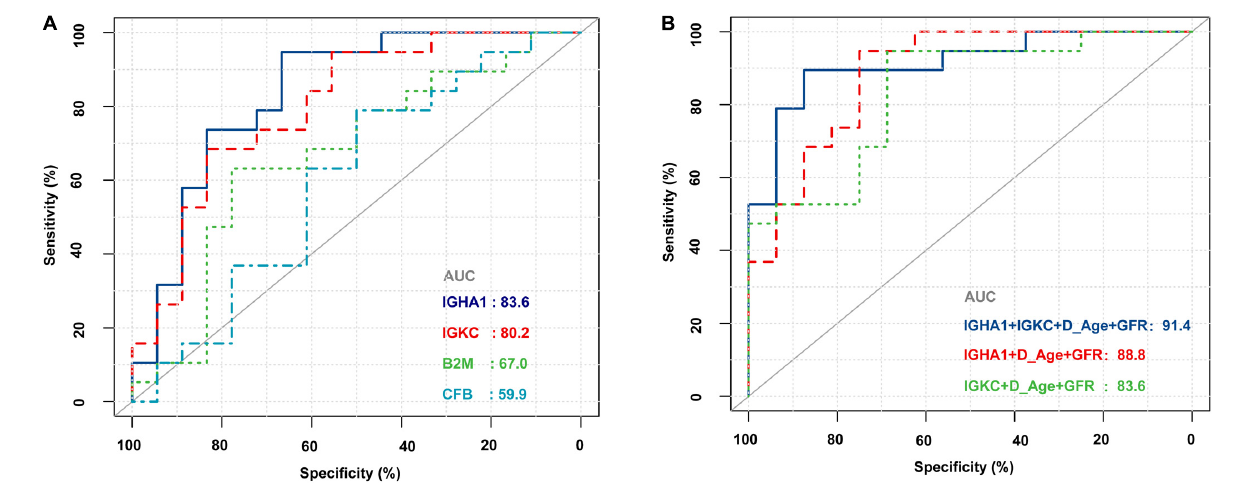
FIGURE 5 | Receiver operating characteristic (ROC) curves of B2M, CFB, IGHA1, and IGKC based on RNA sequencing in PBMCs of renal allograft transplant patients. (A) ROC of B2M, CFB, IGHA1, and IGKC merely based on the expression of RNA-Seq. (B) ROC of different combinations of IGHA1, IGKC, GFR, and donor age. D_Age represents the donor age. IGHA1 + IGKC + D_Age + GFR AUC 91.4% (95% CI: 82–100%). IGHA1 + D_Age + GFR AUC 88.8% (95% CI: 77.8–99.9%). IGKC + D_Age + GFR AUC 83.6% (95% CI: